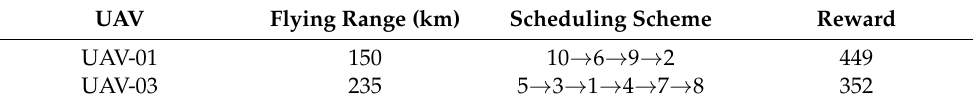
Table 12. Task Re-scheduling Schemes based on Hybrid Contracts to Deal with Platform Failure.